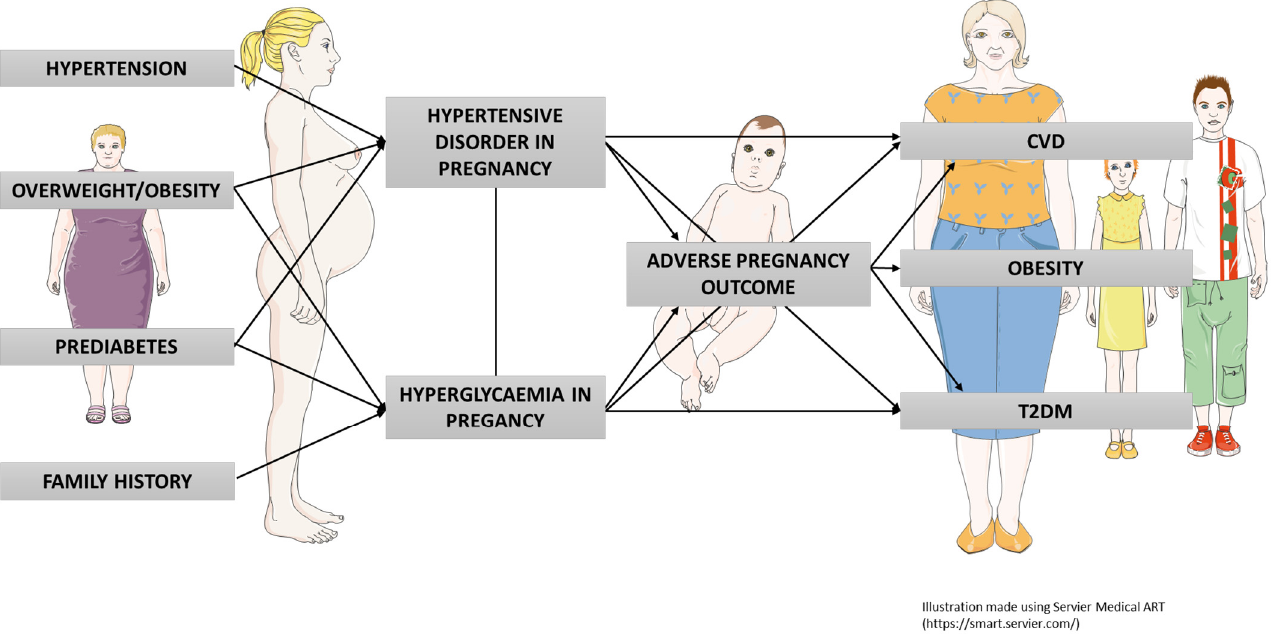
Figure 1. Graphical summary of pregnancy complications and later health implications for mother and child.